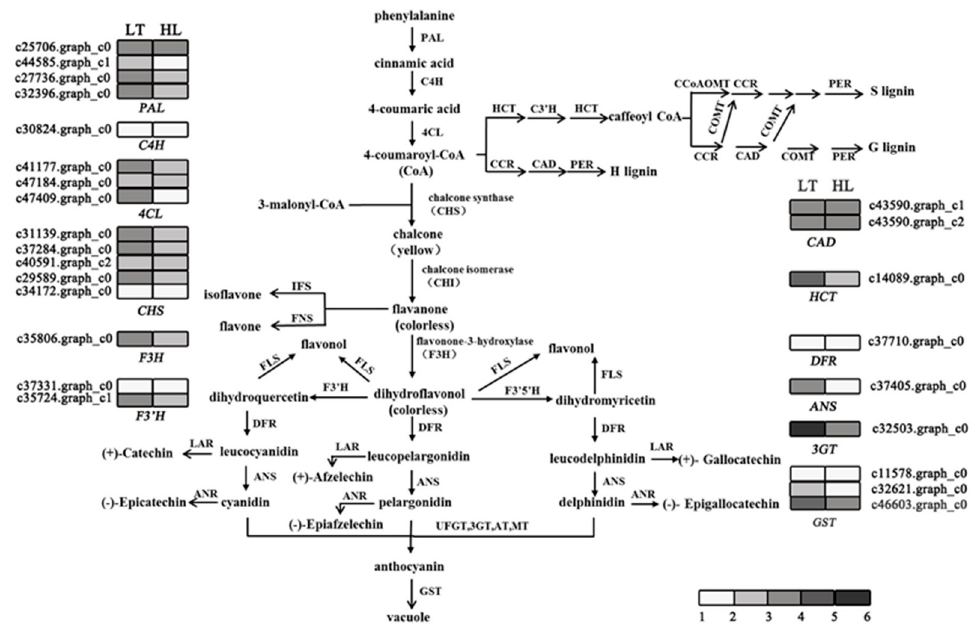
Figure 4. Schematic of physiological and the expression of common differentially expressed genes (DEGs) regulated by both LT and HL conditions in phenylpropanoid and flavonoid biosynthesis in B. semperflorens . ANR, anthocyanidin reductase ; ANS, anthocyanidin synthase; CAD, cinnamyl- alcohol dehydrogenase; C3’H, p-coumaroyl shikimate 3 ′ -hydroxylase; C4H, cinnamic acid 4- hydroxylase; CCoAOMT, caffeoyl CoA O-methyl transferase; CCR, (hydroxy)cinnamoyl CoA reductase; 4CL, 4-coumarate-CoA ligase; CHI, chalcone isomerase; CHS, chalcone synthase;